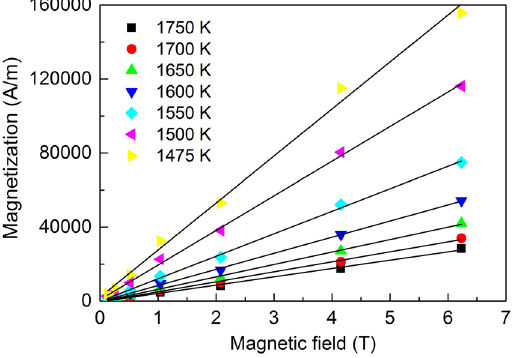
Figure 3. The magnetization as a function of magnetic field intensity of liquid Co measured at different undercooling